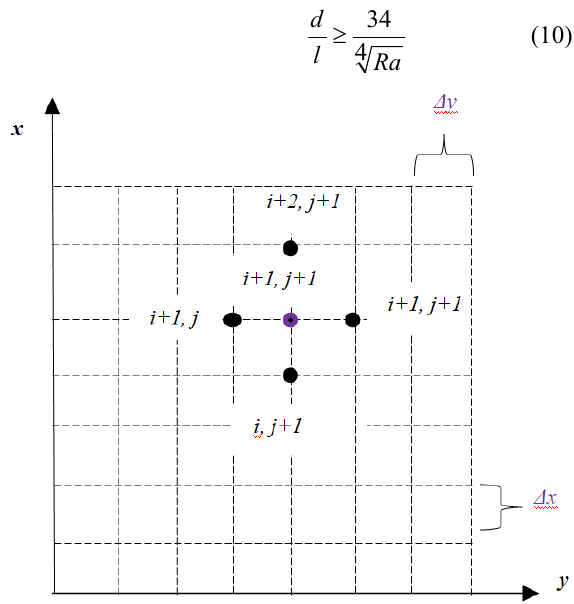
Figure 2. Grid of flow geometry